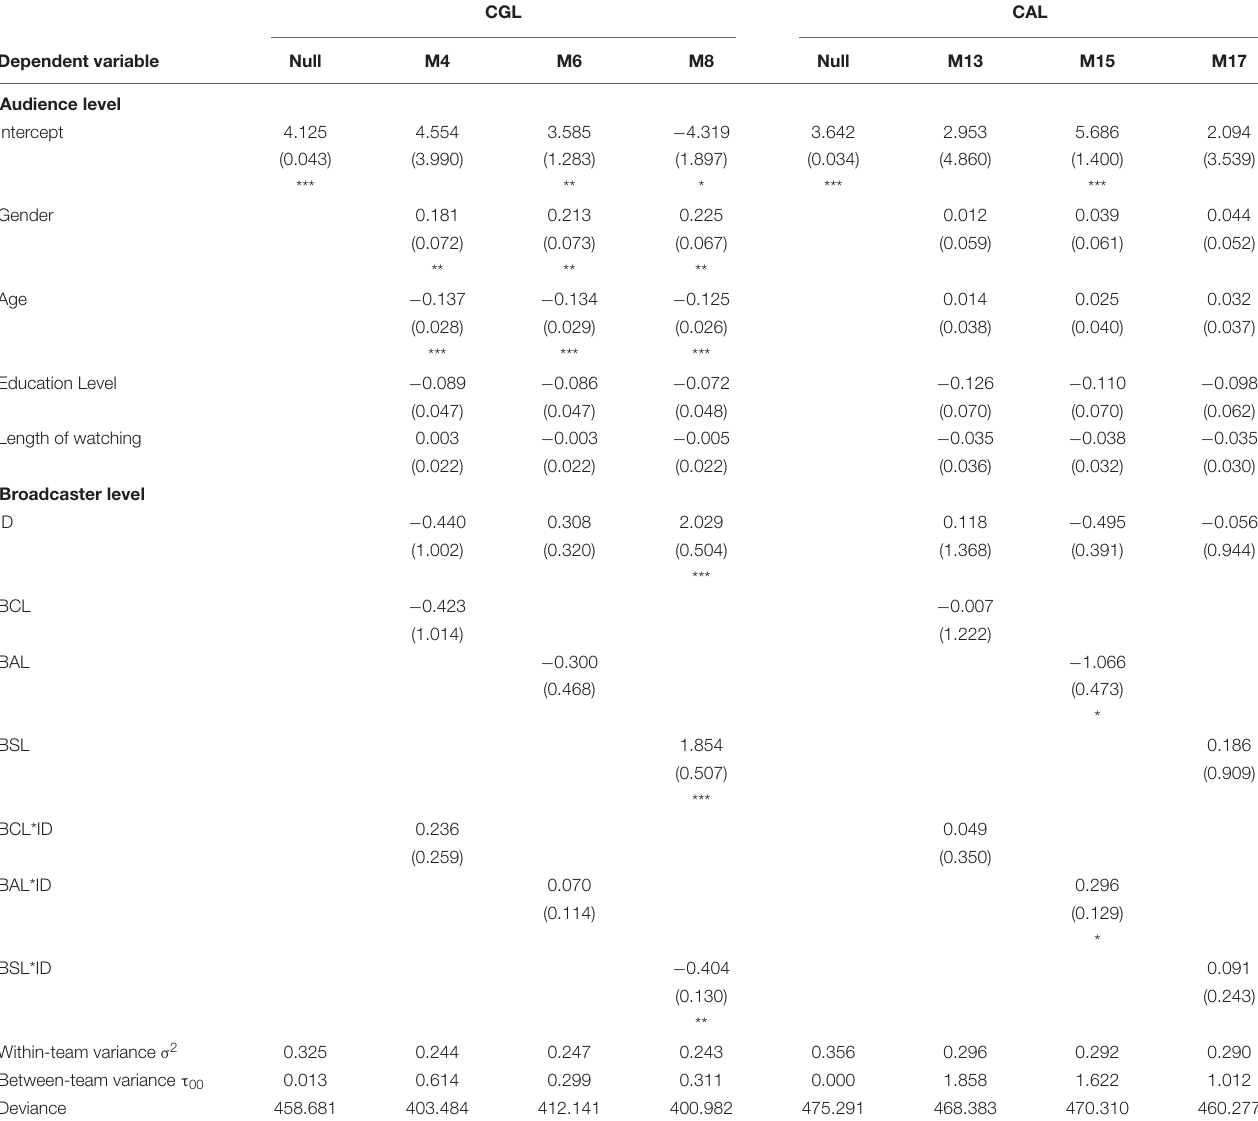
TABLE 6 | The HLM results of broadcaster leadership, ID and